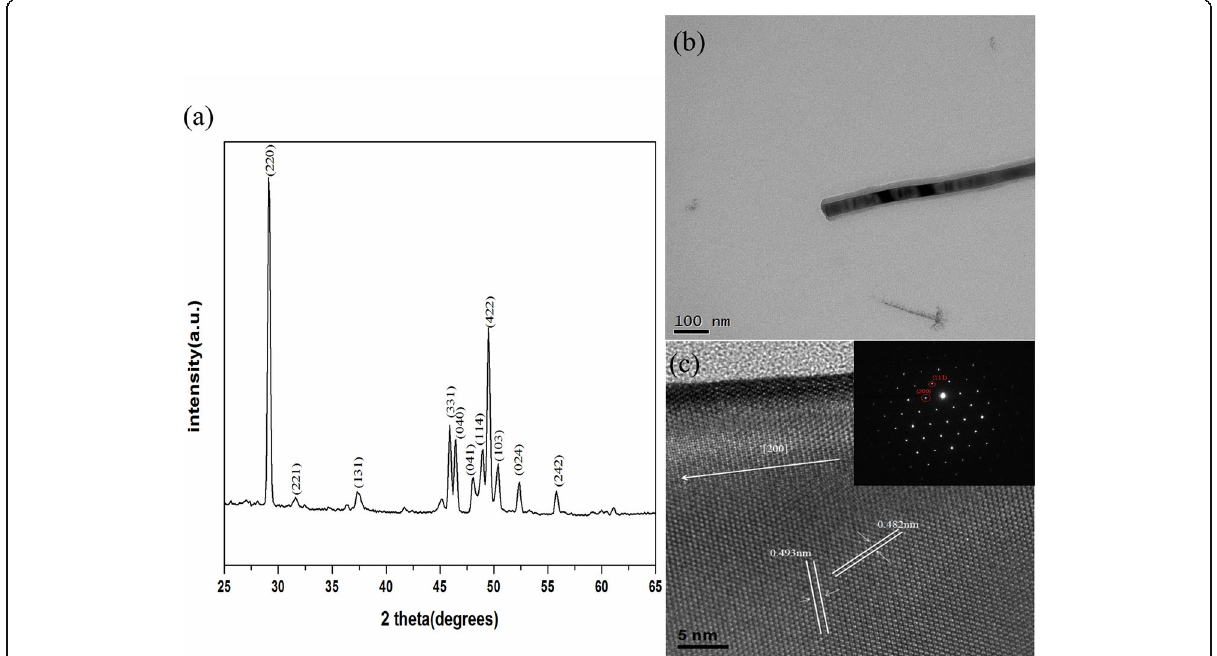
Fig. 2 a XRD pattern for β -FeSi 2 NWs, b a low-magnification TEM image of a β -FeSi 2 NW nanowire, and c HRTEM of a β -FeSi 2 NW. The inset in c is the corresponding diffraction pattern with [011] zone